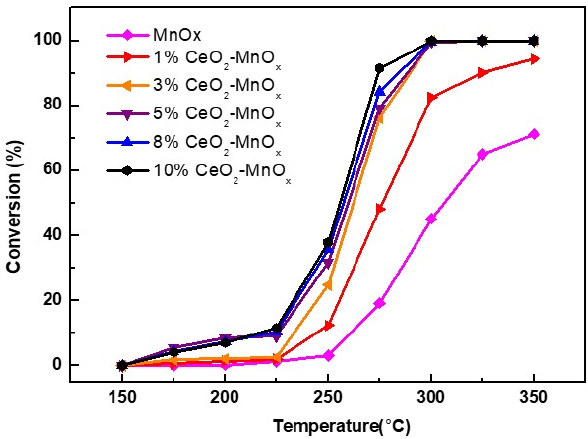
Figure 2. Catalytic activities of w CeO 2 –MnO X -300 for toluene oxidation.